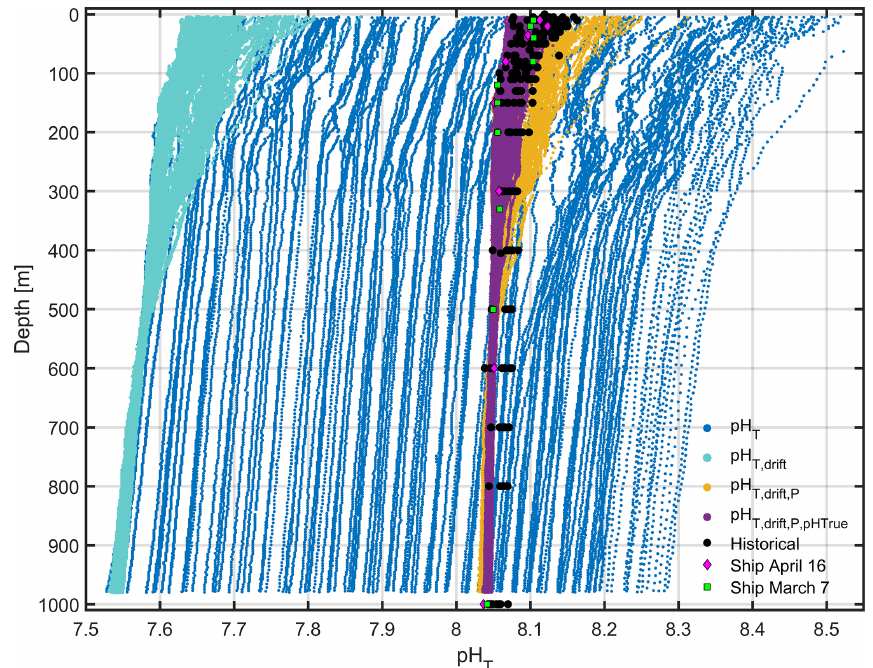
Figure B2. A comparison of glider pH T after various corrections have been applied. Raw pH T (blue) is corrected for drift (turquoise) and subsequently for pressure effects (yellow). Finally pH T is compared with “true” ship pH T and corrected (purple). Historical pH T anomalies (black) collected in March and April between 1998 and 2013 are shown for comparison, alongside the ship pH T on 7 March (green squares) and 16 April (pink